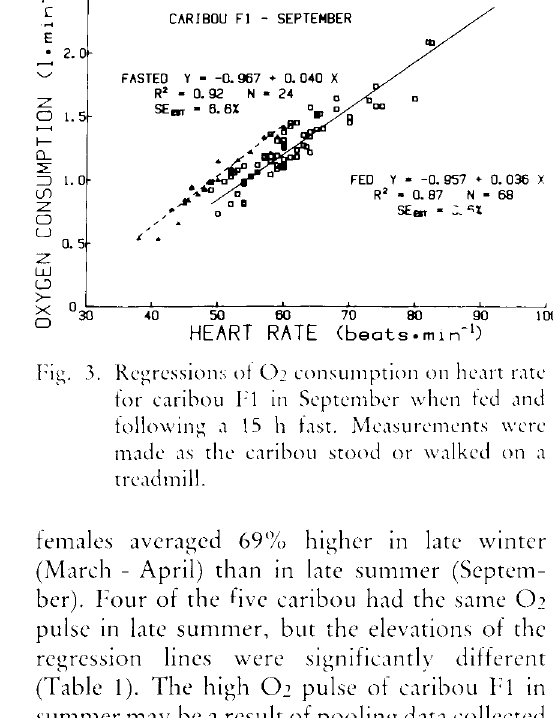
Table 1. Summary of analvses of covariance comparing regression lines relating V O2 to heart rates of caribou. No. of